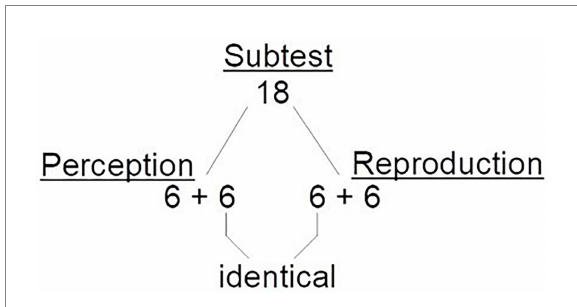
FIGURE 2 Distribution of the items per rhythm/tempo subtest of the PROMS. The current adaptation of the PROMS is depicted. The original battery comprises 18 items for each subtest, including 18 for the rhythm and 18 tempo subtests. In both subtests, 12 of the 18 stimuli were selected for the perceptual items, and 12 for the reproduction items. Of the 12 stimuli, 6 were identical between the perception and reproduction subtest of the same music dimension to control for possible training effects. Supplementary Table S1 provides a detailed overview over which 12 items were